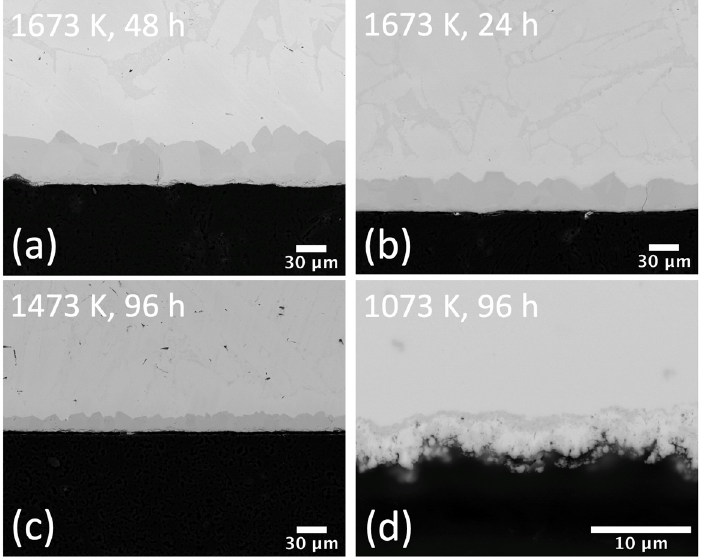
Figure 1. SEM images of carburized Zr samples through solid state reaction at ( a ) 1673 K for 48 h ( b ) 1673 K for 24 h, ( c ) 1473 K for 96 h, and ( d ) 1073 K for 96 h.